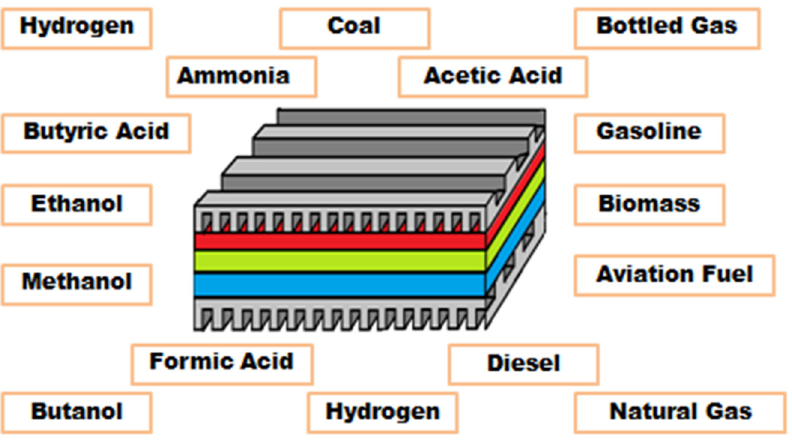
Figure 9. Fuels for solid oxide fuel cell (SOFC).